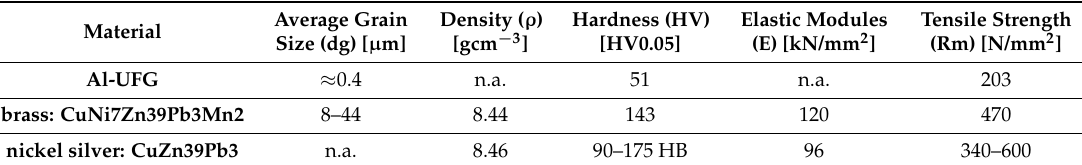
Table 2. Mechanical properties of the investigated materials.